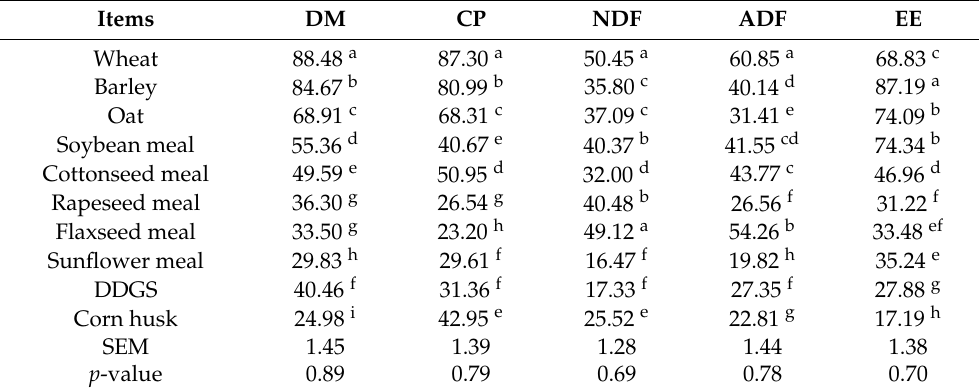
Table 5. Rumen digestibility of concentrate nutrients during whole day (24 h) (%, dry